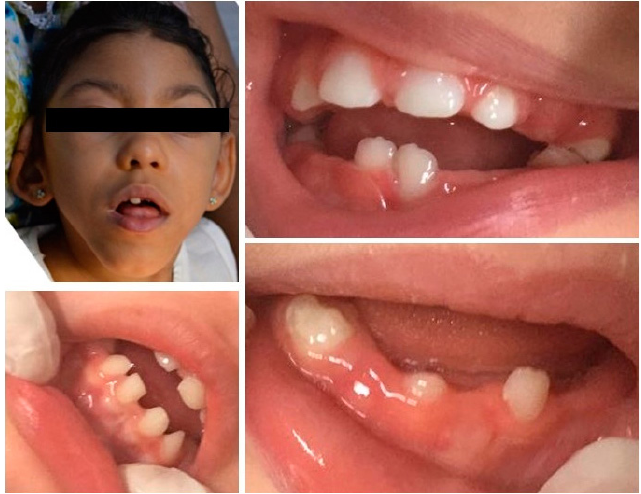
Figure 1- Intraoral profile of babies with congenital ZIKV infection exhibiting shortening of upper and lower lingual frenums